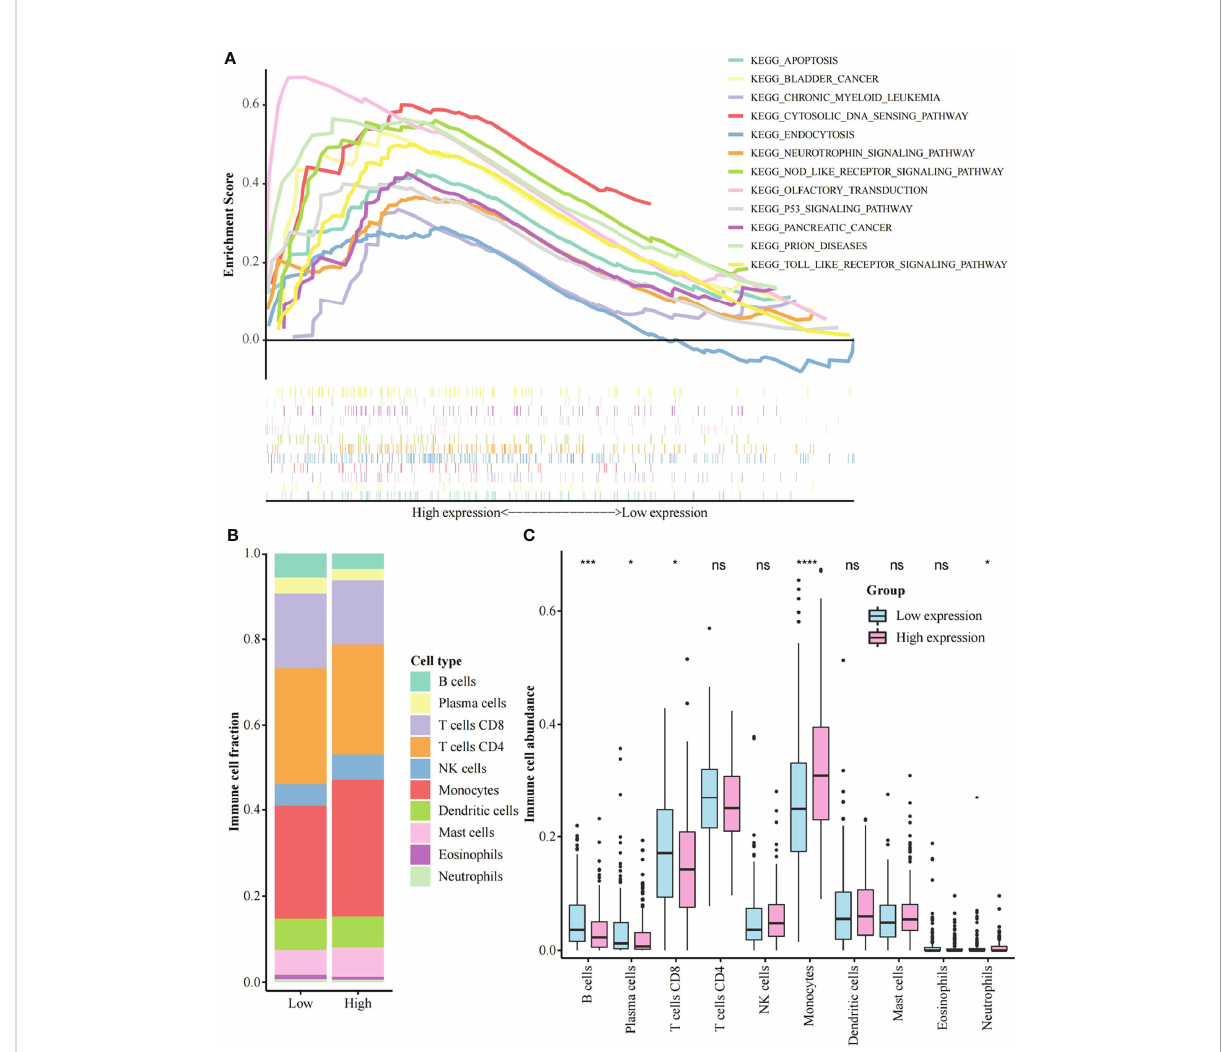
FIGURE 3 Gene set enrichment analysis and immune cell abundance analysis. (A) A merged enrichment plot including the enrichment score and gene sets. 12 pathways are shown here; (B) Proportion of immune cells in the low and high GJB2 expression group; (C) Immune cell abundance analysis between the low and high GJB2 expression group. *p < 0.05, ***p < 0.001, ****p < 0.0001. ns: not signi fi